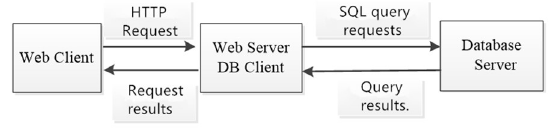
Figure 1. Principle of B/S